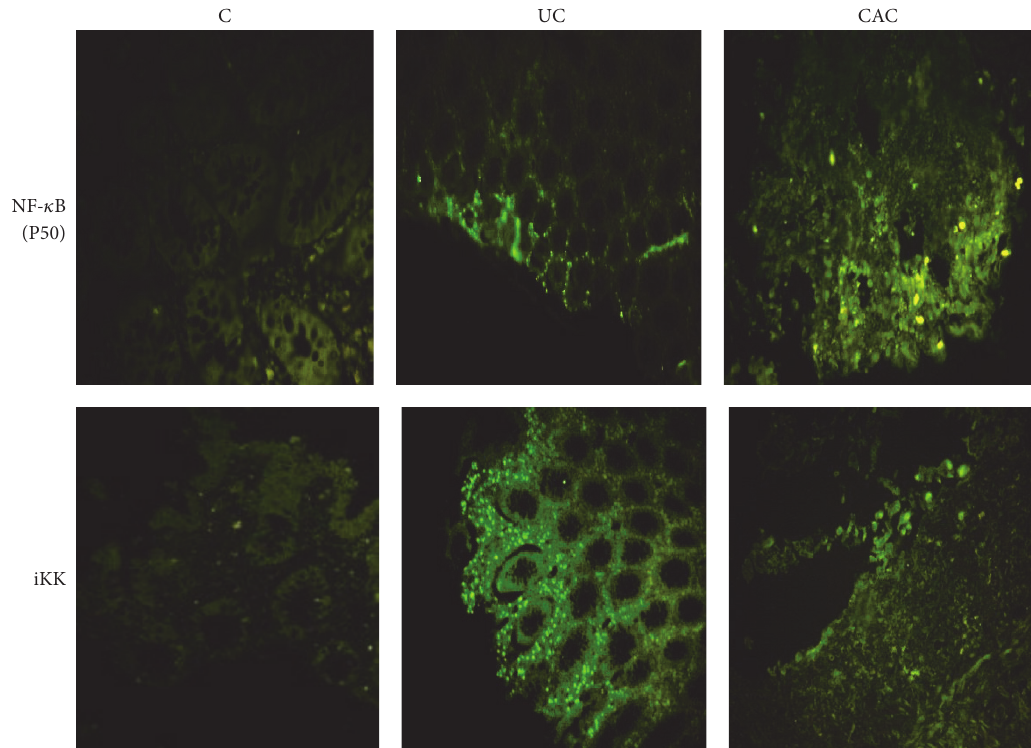
Figure 9: The expression of NF- 𝜅 B (P50) and ikk 𝛾 in colonic mucosa of UC and CAC patients detected by IF. NF- 𝜅 B (score 3) and ikk 𝛾 (score 3) expression was upregulated in colonic mucosa of active UC and CAC patients compared with control (score 0) (UC: ulcerative colitis, 𝑛 = 6 ; CAC: colitis associated cancer, 𝑛 = 4 ; C: control, normal mucosa, 𝑛 = 3 ).